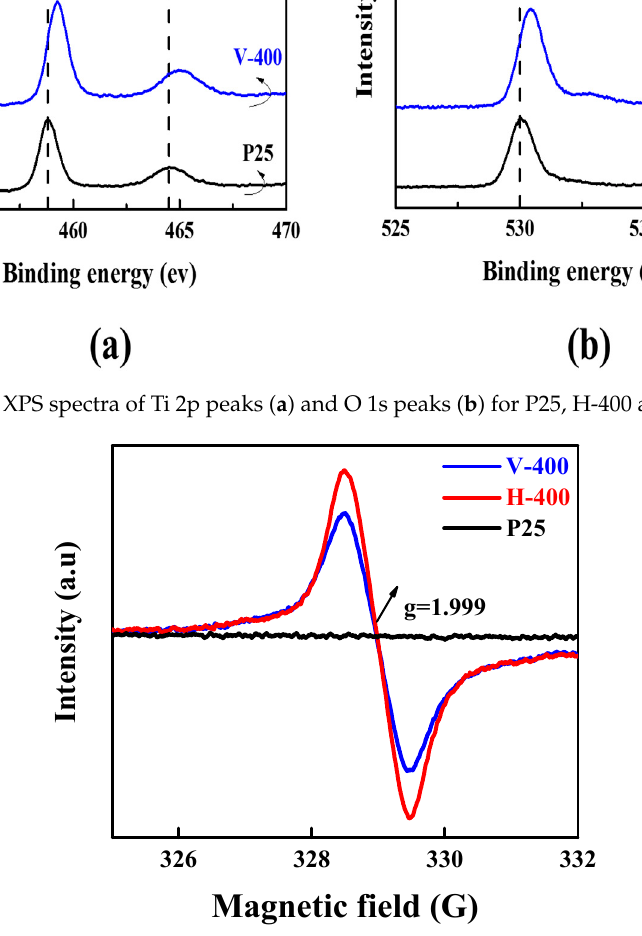
Figure 4. EPR spectra recorded at room temperature for P25, H-400 and V-400.